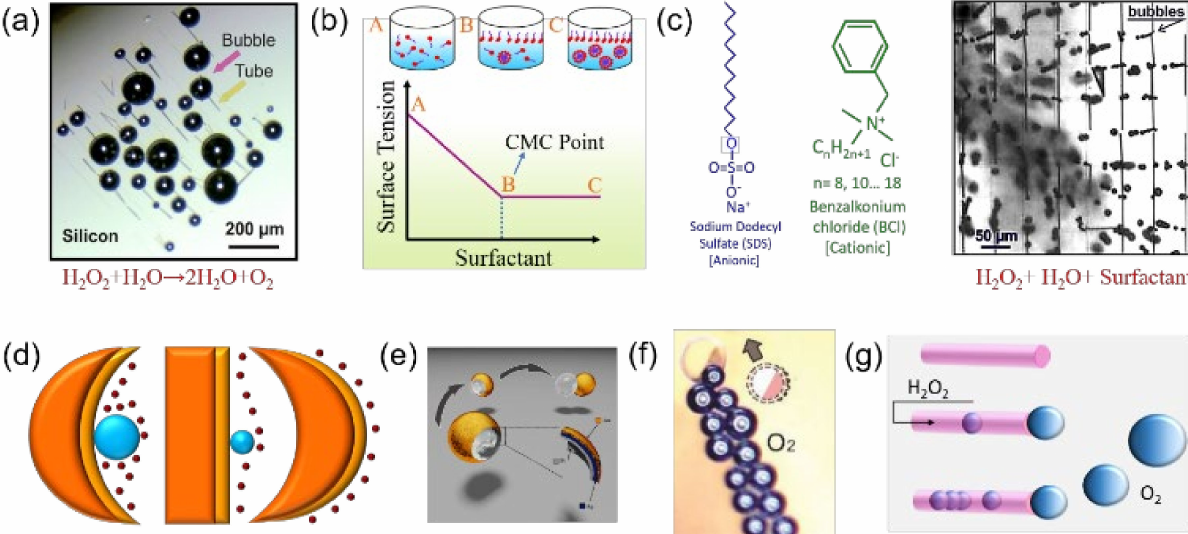
Figure 4. ( a ) Catalytic micromotors in an aqueous solution of H 2 O 2 (without surfactant). Bubbles are indicated by the pink arrow, which grows due to the H 2 O 2 decomposition into H 2 O and O 2 because of the Pt catalyst inside the microtube (yellow arrow). The microbubble diameter was more than 100 µ m and could not detach from the microtube. Reproduced with permission from Ref. [88]. ( b ) (Top image) Schematic process of bubble stabilization by surfactant absorption and formation of micelles. (Bottom image) Plot of the surface tension versus surfactant concentrations. Reproduced with permission from Ref. [88]. ( c ) Examples of different surfactant types (anionic and cationic). Effect of surfactant addition (common dish soap, “Fit-waschmittel”) on the reduction of bubble size. Reproduced with permission from Ref. [88]. ( d ) Schematic representation of bubble growth on the concave, flat and convex surfaces. ( e ) Schematic of bubble emission from the concave surface of nanoshell catalytic motors. Reproduced with permission from Ref. [93], Copyright 2013, American Chemical Society. ( f ) Optical micrograph of long tails of O 2 bubbles produced by an individual Pt-on-Caps micromotor in H 2 O 2 and dish soap solution. Reproduced with permission from Ref. [94], Copyright 2019, IOP Publishing Ltd. ( g ) Schematic illustration of oxygen bubble nucleation and recoiling from the catalytic